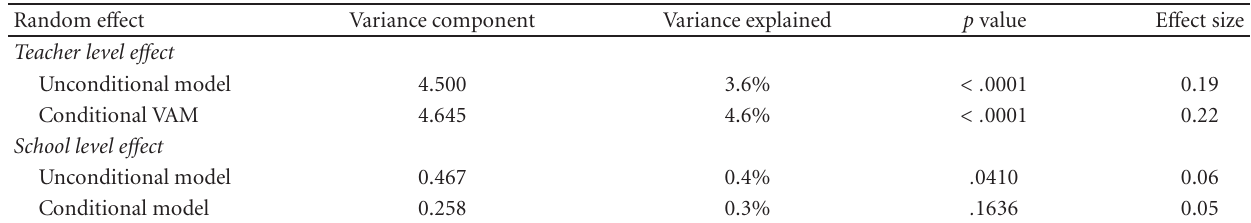
Table 2: Estimation of variance explained, significance, and e ff ect size at teacher and school